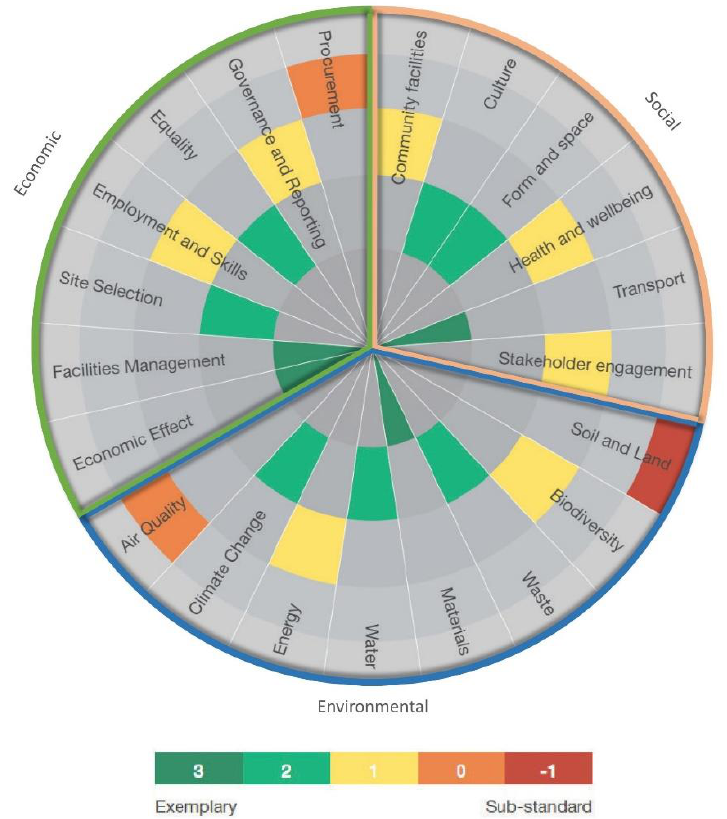
Figure 2. Output of SPeAR showing individual criteria and evaluation traffic light [41] supplemented by the assignment to three sustainability dimensions in accordance with [41].